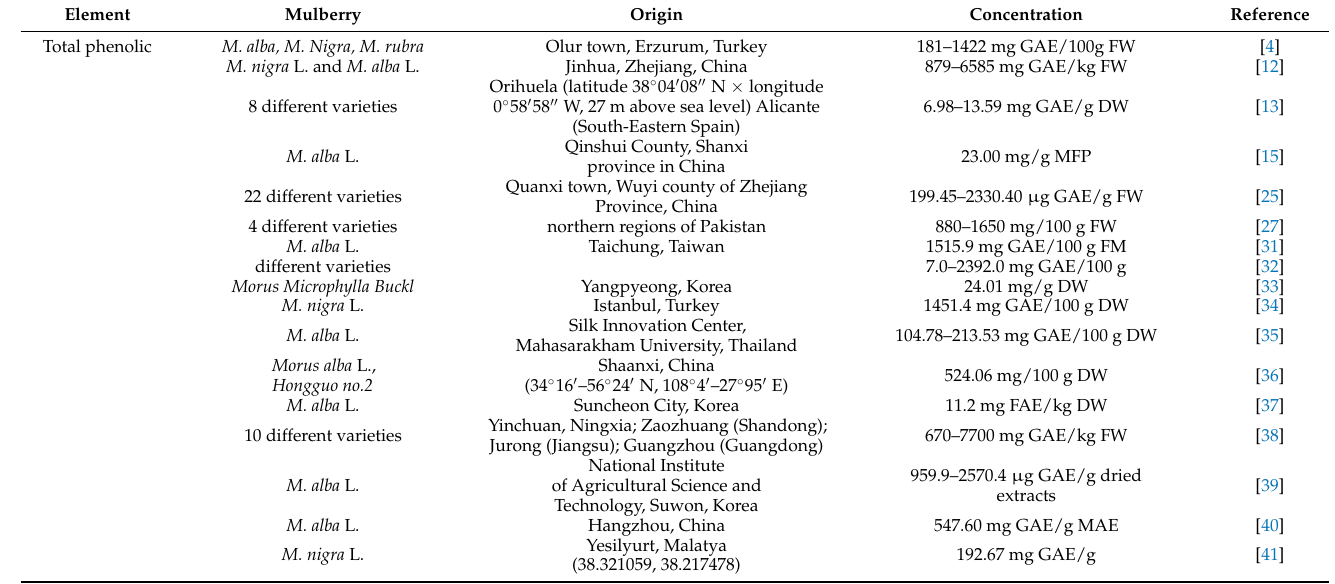
Table 1. Total phenol and total flavonoid content in